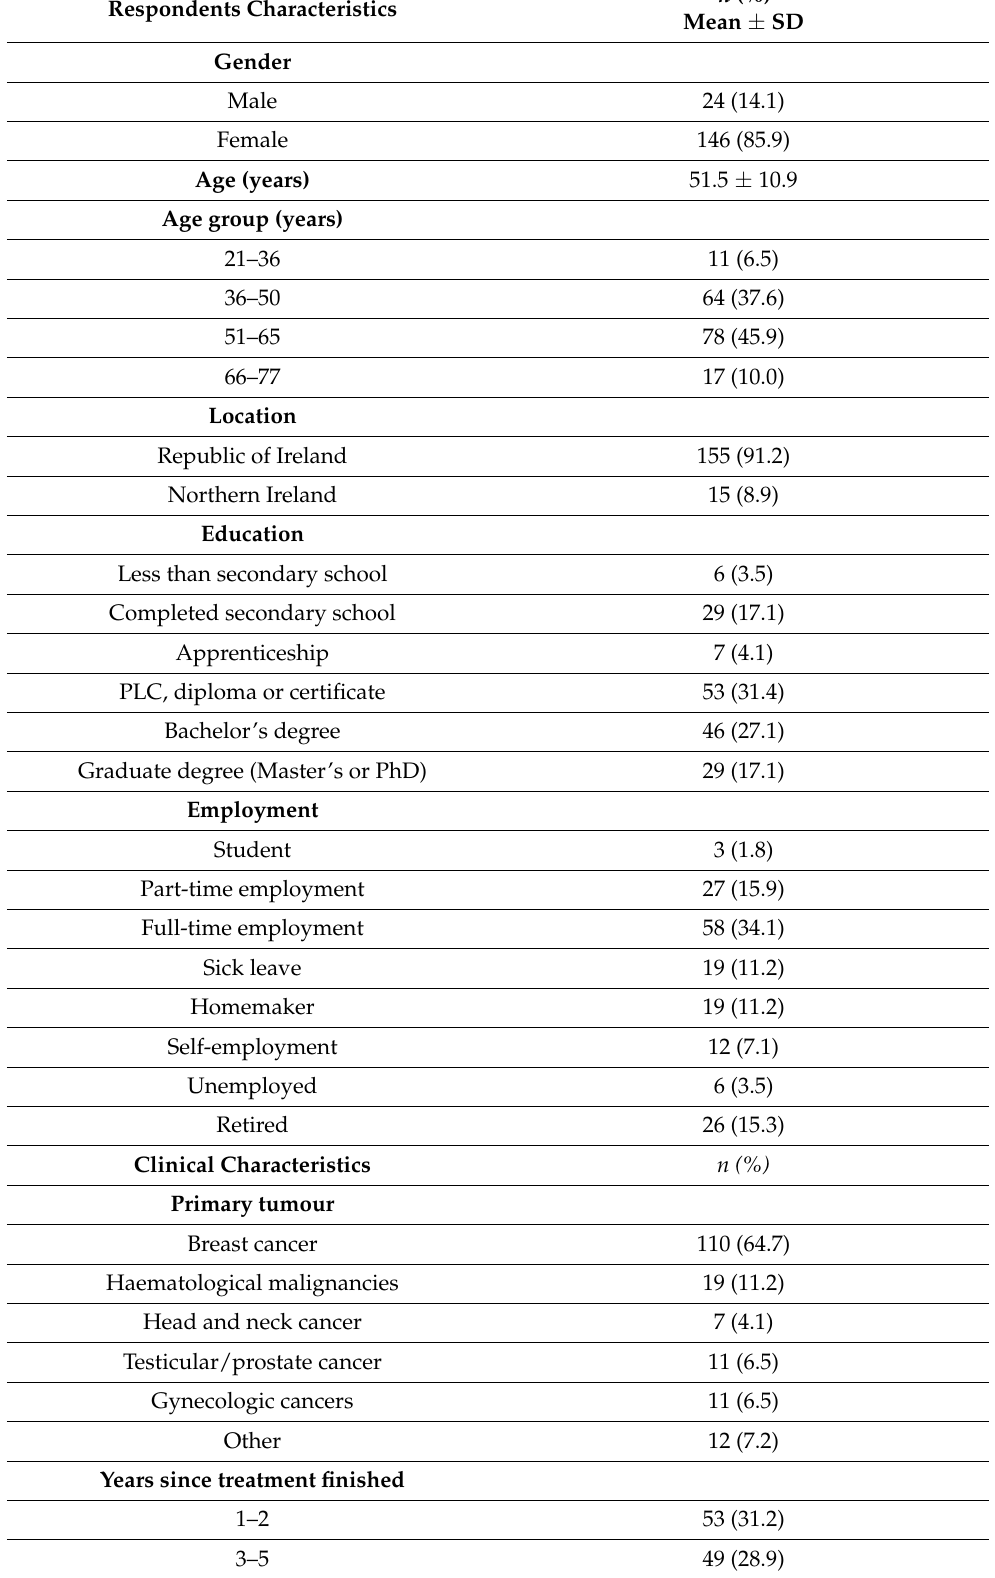
Table 1. Summary of the demographic and clinical characteristics of the respondents to the survey (n =